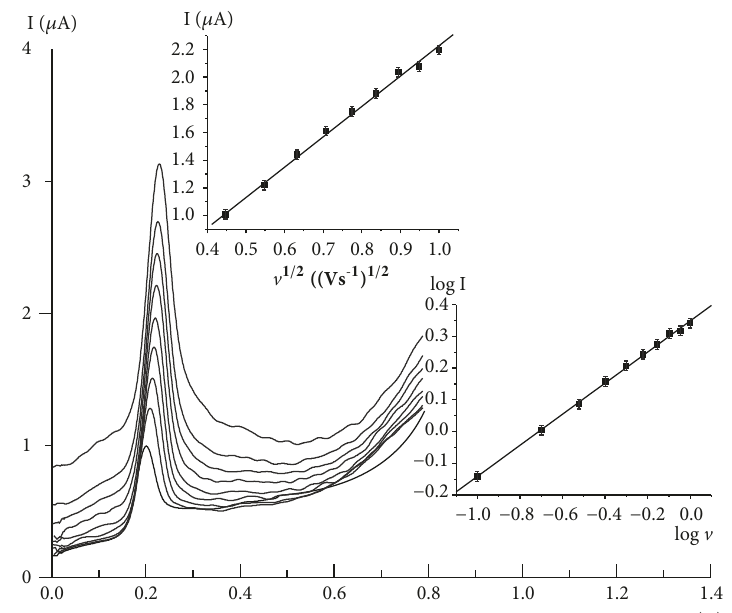
Figure 7: Polarogramms of 5 ⋅ 10 −5 mol ⋅ L −1 BC in the potential range from 0.0 to -1.4 V for the scan rate values from 0.1 to 1.0 V s −1 , C PMS = 1 ⋅ 10 −3 mol ⋅ L −1 , pH 4.0, and C buffer =0.2 mol ⋅ L −1 . Insets: the dependences of 𝐼 p vs. V 1/2 and log 𝐼 p vs. log V